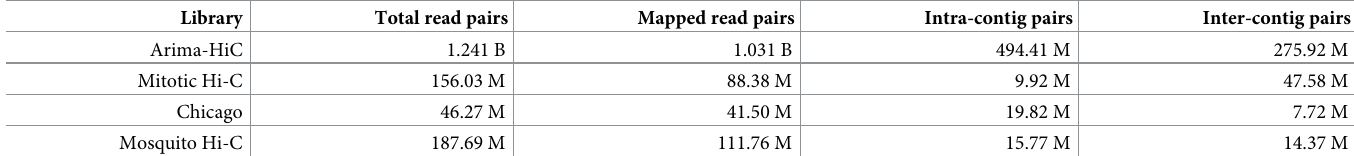
Table 1. Hi-C library statistics for different datasets used in this paper. Mapped read pairs denote the total number of Hi-C read pairs aligned before mapping quality filtering. Intra-contig read pairs account for the read pairs where both the reads align to same contig and inter-contig read pairs account for the read pairs where both reads align to different